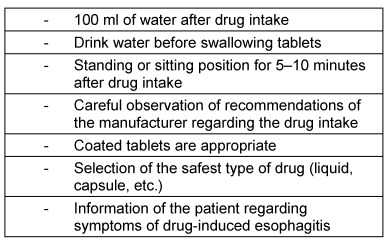
Recommendations for the prevention of drug-induced esophagitis